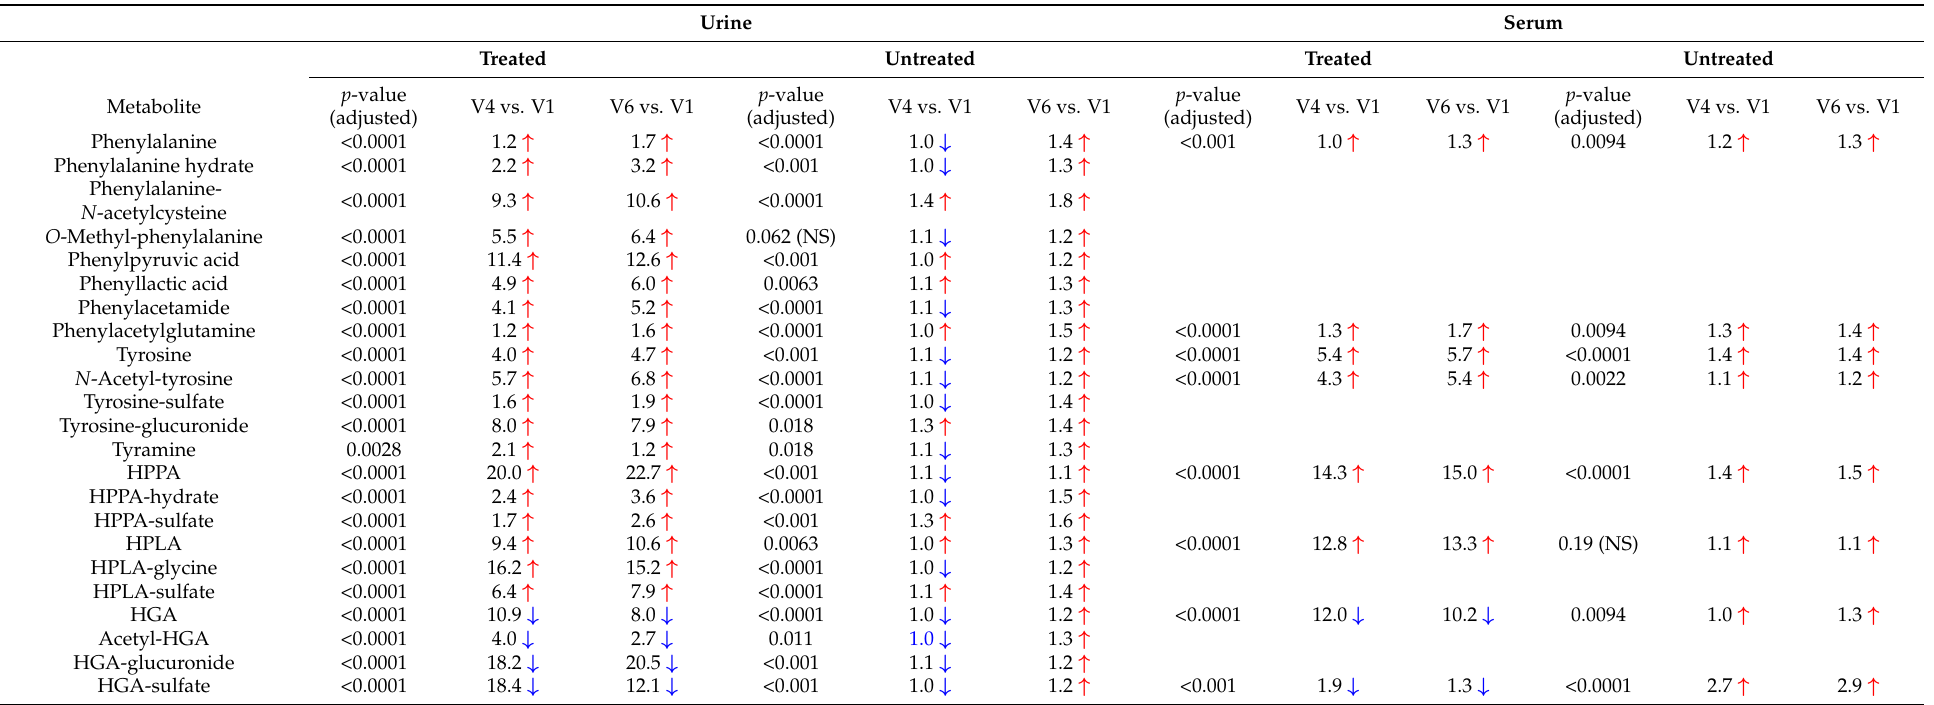
Table 3. Summary of changes in urine and serum metabolite abundance between treatment groups and visits. Visits 1 (V1), 4 (V4) and 6 (V6) refer to baseline, 24 and 48 months, respectively. Patients in the treated group were on nitisinone at V4 and V6. Red arrows indicate increased abundance and blue arrows indicate decreased abundance. The p -value significance threshold was p < 0.05 (Benjamini–Hochberg false discovery rate adjusted). ‘NS’: statistically